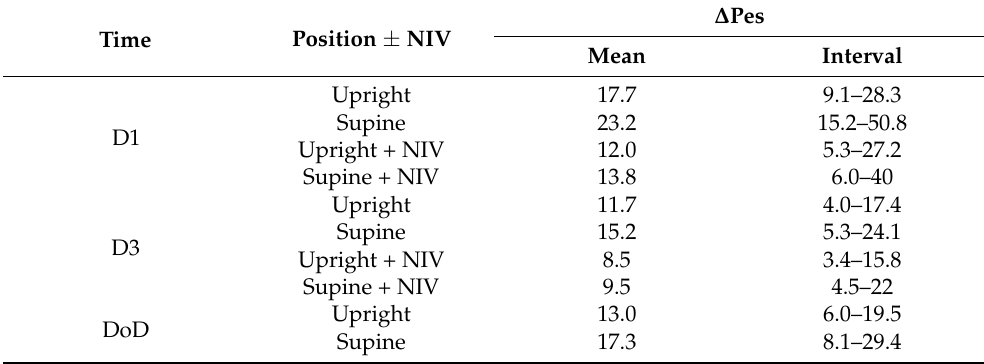
Table 2. Recorded mean ∆ Pes